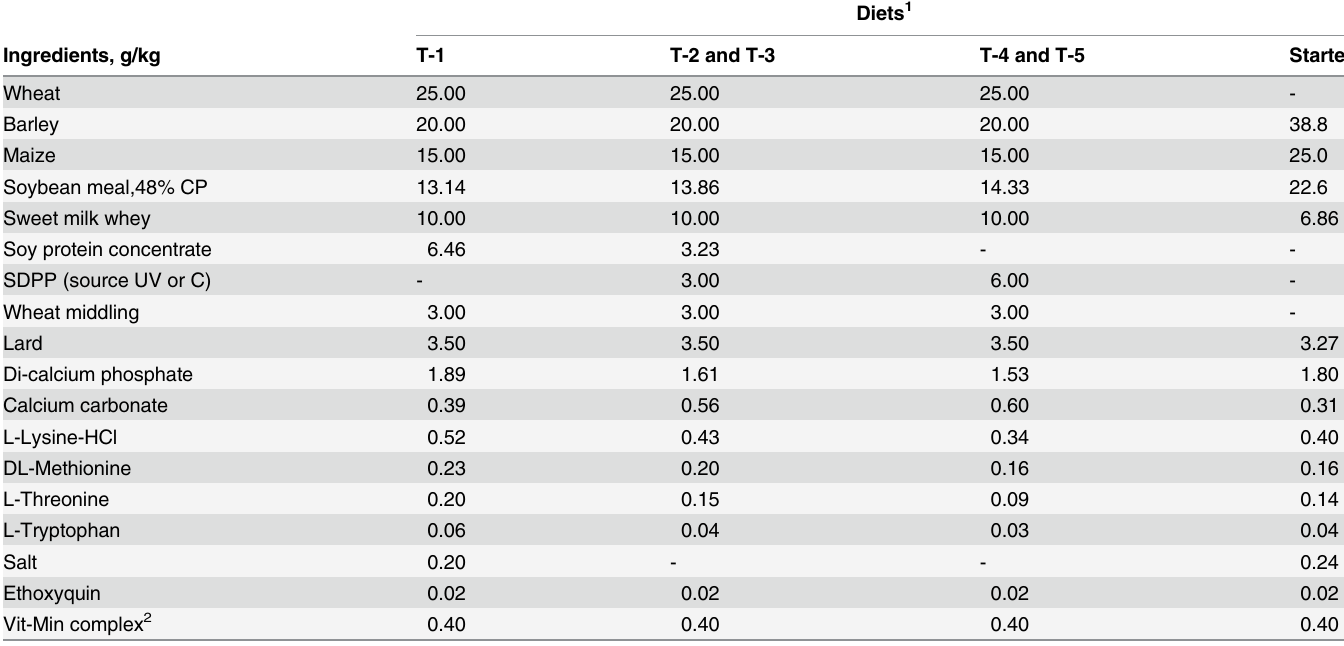
Table 2. Composition of the diets used in Experiment 2, as-fed